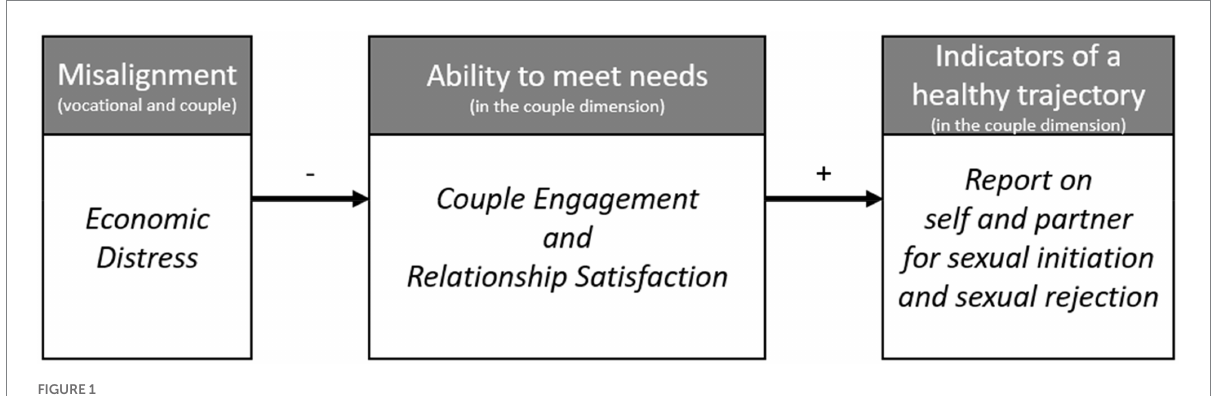
FIGURE 1 Related tenets of MFDT and their